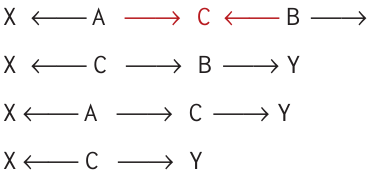
Figure 2. Finding the backdoor paths after eliminating the exposure outcome relationship and identifying the colliders